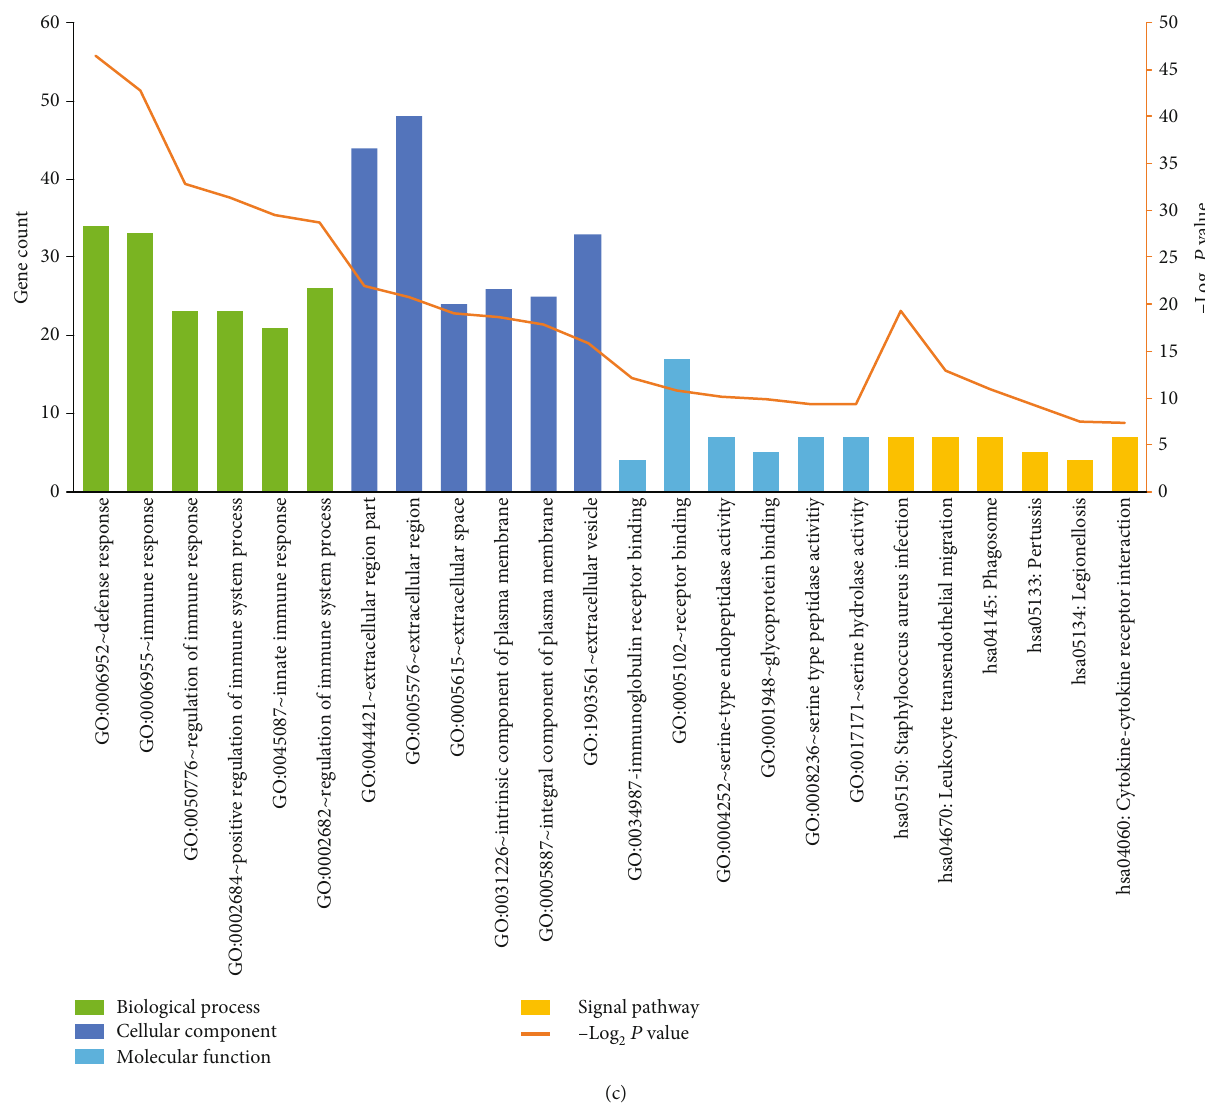
Figure 1: (a) Work fl ow of the analysis. (b) Volcano plot of di ff erentially expressed genes; red represents upregulated genes, whereas blue represents downregulated genes. (c) Signi fi cance of GO and pathway enrichment of